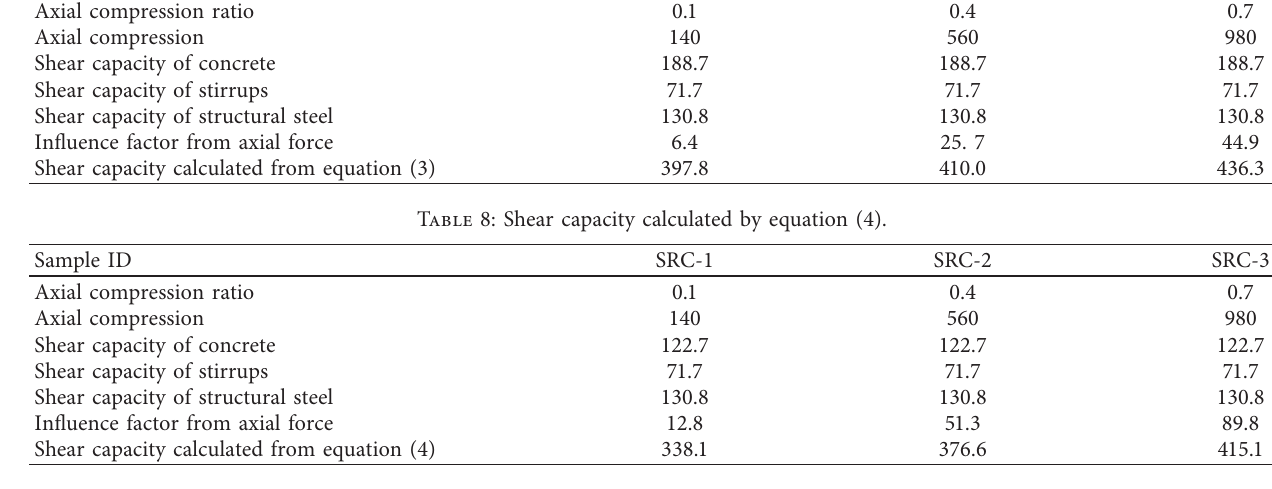
Table 9: Comparison between theoretical values and measured